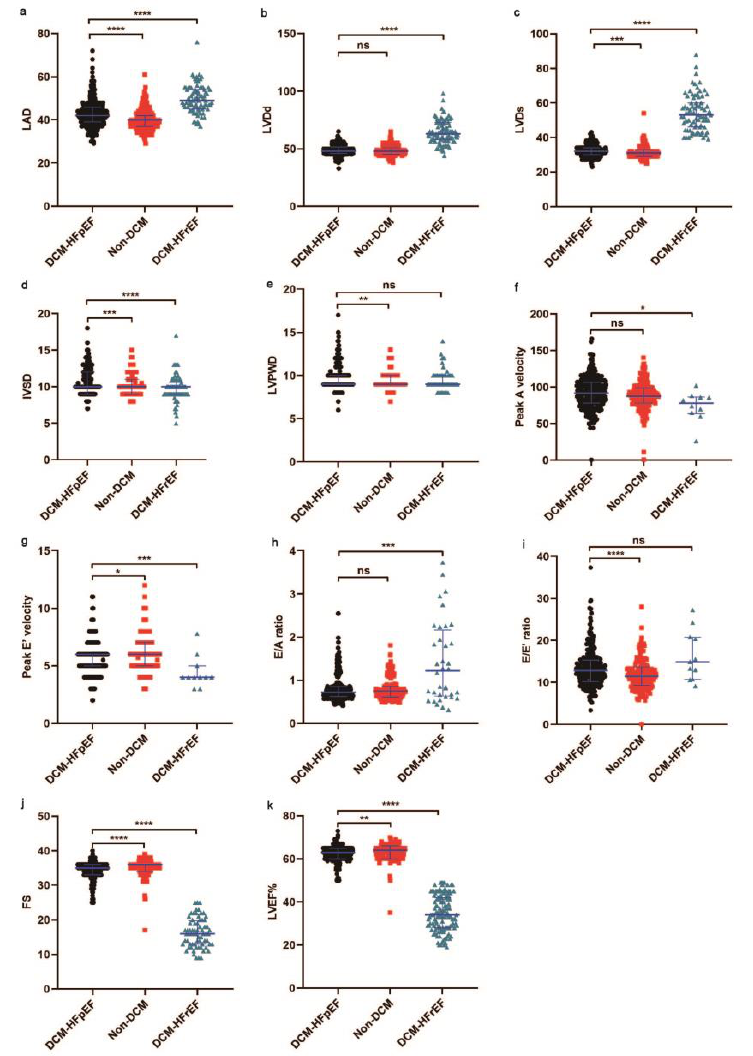
Figure 3. Comparison of echocardiography data during hospitalization of DCM-HFpEF vs. non-DCM and DCM-HFpEF vs. DCM-HFrEF. (a) LAD was higher in DCM-HFrEF vs. DCM-HFpEF and lower in non-DCM vs. DCM-HFpEF. (b, c) LVDd and LVDs were higher in DCM-HFrEF vs. DCM-HFpEF. (d) IVSD was higher in DCM-HFpEF vs. non-DCM and DCM-HFrEF. (e) LVPWD was higher in DCM-HFpEF vs. non-DCM. (f) Peak A velocity was higher in DCM-HFpEF vs. DCM-HFrEF. (g) Peak E’ velocity was higher in non-DCM vs. DCM-HFpEF and lower in DCM-HFrEF vs. DCM-HFpEF. (h) E/A ratio was higher in DCM-HFrEF vs. DCM-HFpEF. (i) E/E’ was lower in non-DCM vs. DCM-HFpEF. (j) FS was higher in non-DCM vs. DCM-HFpEF and lower in DCM-HFrEF vs. DCM-HFpEF. (k) LVEF% was higher in non-DCM vs. DCM-HFpEF and lower in DCM-HFrEF vs. DCM-HFpEF. LVEF: left ventricular ejection fraction; LAD: left atrial diameter; IVSD: ventricular septum diameter; LVPWD: left ventricular posterior wall diameter; LVDd: left ventricular diameter in diastole; LVDs: left ventricular diameter in systole; FS: fractional shortening; Peak A velocity: the maximum early transmitral flow velocity in atrial systole; Peak E velocity: the maximum early transmitral flow velocity; E/A ratio: the ratio of the early (E) to late (A) ventricular filling velocities; E/E’ ratio: the ratio of mitral peak velocity of the early filling (E) to early diastolic mitral annular velocity (E). DCM: diabetic cardiomyopathy; HFrEF: heart failure with reduced ejection fraction; HFpEF: heart failure with preserved ejection fraction. Black represents DCM-HFpEF, red represents non-DCM, green represents DCM-HFrEF. * p < 0.05. ** p < 0.01. *** p < 0.005. **** p < 0.001.